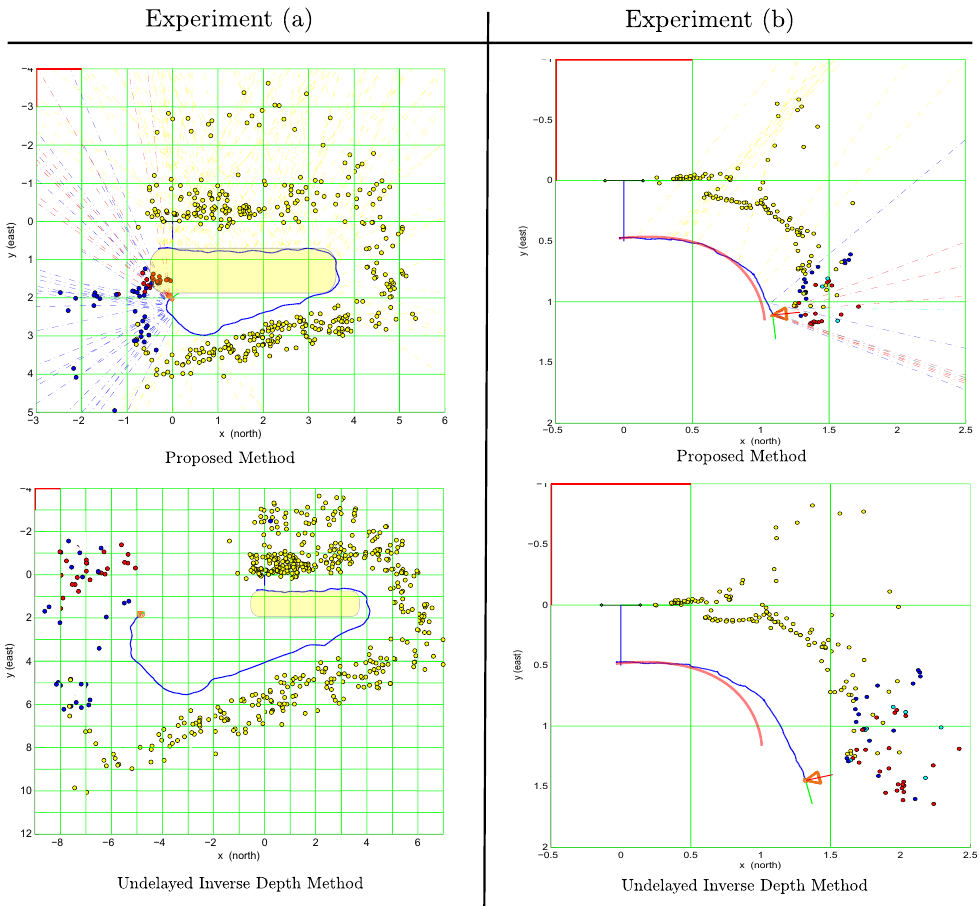
Figure 7. An x–y view corresponding to the camera trajectory and map estimates obtained from two different test cases. The right column shows the results from experiment ( a ), and the left column shows the results from experiment ( b ). In both cases, upper plots show the estimates obtained with the proposed method, whereas lower plots show the estimates obtained with the Undelayed Inverse Depth (UID) method. In experiment (a), the real path is described approximately by a rectangle with rounded edges. In experiment (b), the real path is indicated by a red curved line.